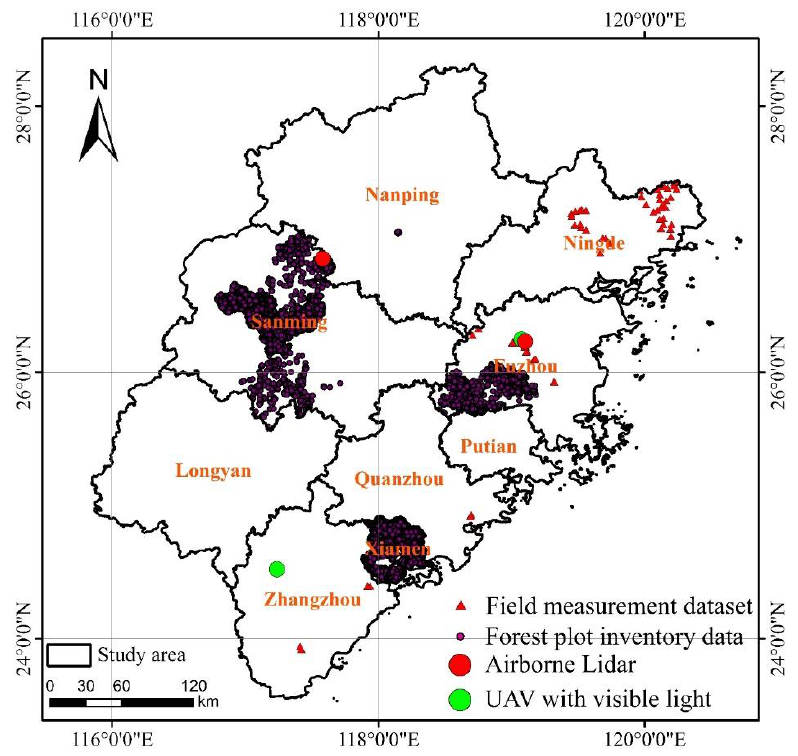
Figure 2. Distribution of field survey sample data in the study area. The forest plot inventory data were divided into a plot according to the stand condi- tions, the stand factors, and the harvesting methods that were consistent with the stand. The forest plot data include information on the average tree height, the average diameter at breast height, the denseness, and the stocking volume. The forest plot inventory data that were used in this study include 66,413 forest plots in Mingxi County in 2008, Xiamen in 2009, Jiangle County in 2015, 2019, and 2021, the Wanmulin reserve in Nanping city in 2016, Yongtai County in 2021, and Yongan County in 2021. The field measurement data were collected from October 2020 to December 2021. The average tree heights in a rectan- gular sample plot with a side length of 30 m were measured and recorded, with measuring tools such as a tape measure, a breast height ruler, a laser range altimeter, and the HUACE i70 GNSS receiver. 3. Methods The technical flow of this study is shown in Figure 3. The first part of the research involved fitting curves between the average forest height from inventory plots and the forest age estimated from Landsat time series. Second, the forest age was estimated using time series Landsat satellite data. The time nodes of forest disturbance and restoration were obtained based on the LandTrendr algorithm using long-time-series Landsat data, and Fujian was divided into disturbance areas and non-disturbance areas. The forest stand age can be calculated in a disturbance area based on the recovery node; forest stand ages in the non-disturbance area were labeled as greater than the maximum forest age in the disturbance areas. Third, the canopy height model and the accuracy evaluation were in- verted. The average tree height was calculated based on the obtained forest age factor and the growth curves of the different forest types in Fujian, and it was merged with the GEDI_V27 to obtain the canopy height model of Fujian in 2020. The sample data were used as reference data to evaluate and analyze the accuracy of the modified canopy height model and the GEDI_V27 canopy height model obtained by the proposed method.